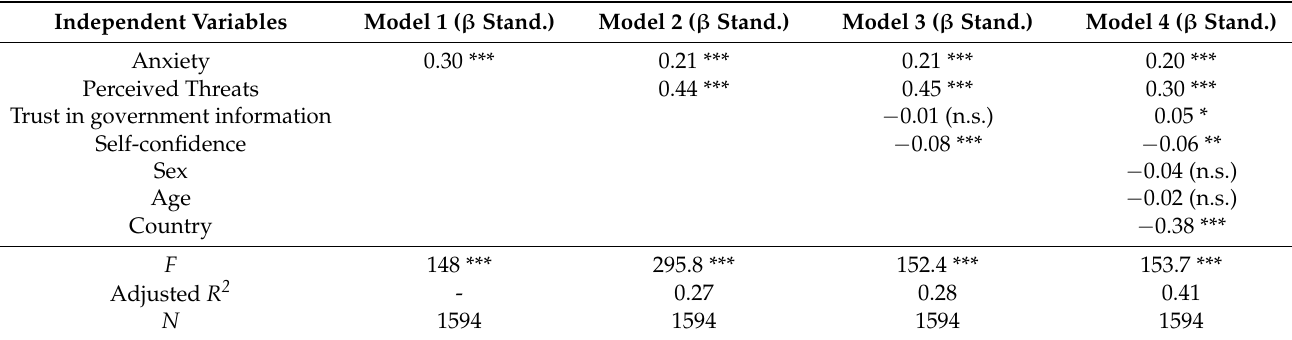
Table 3. Regressions